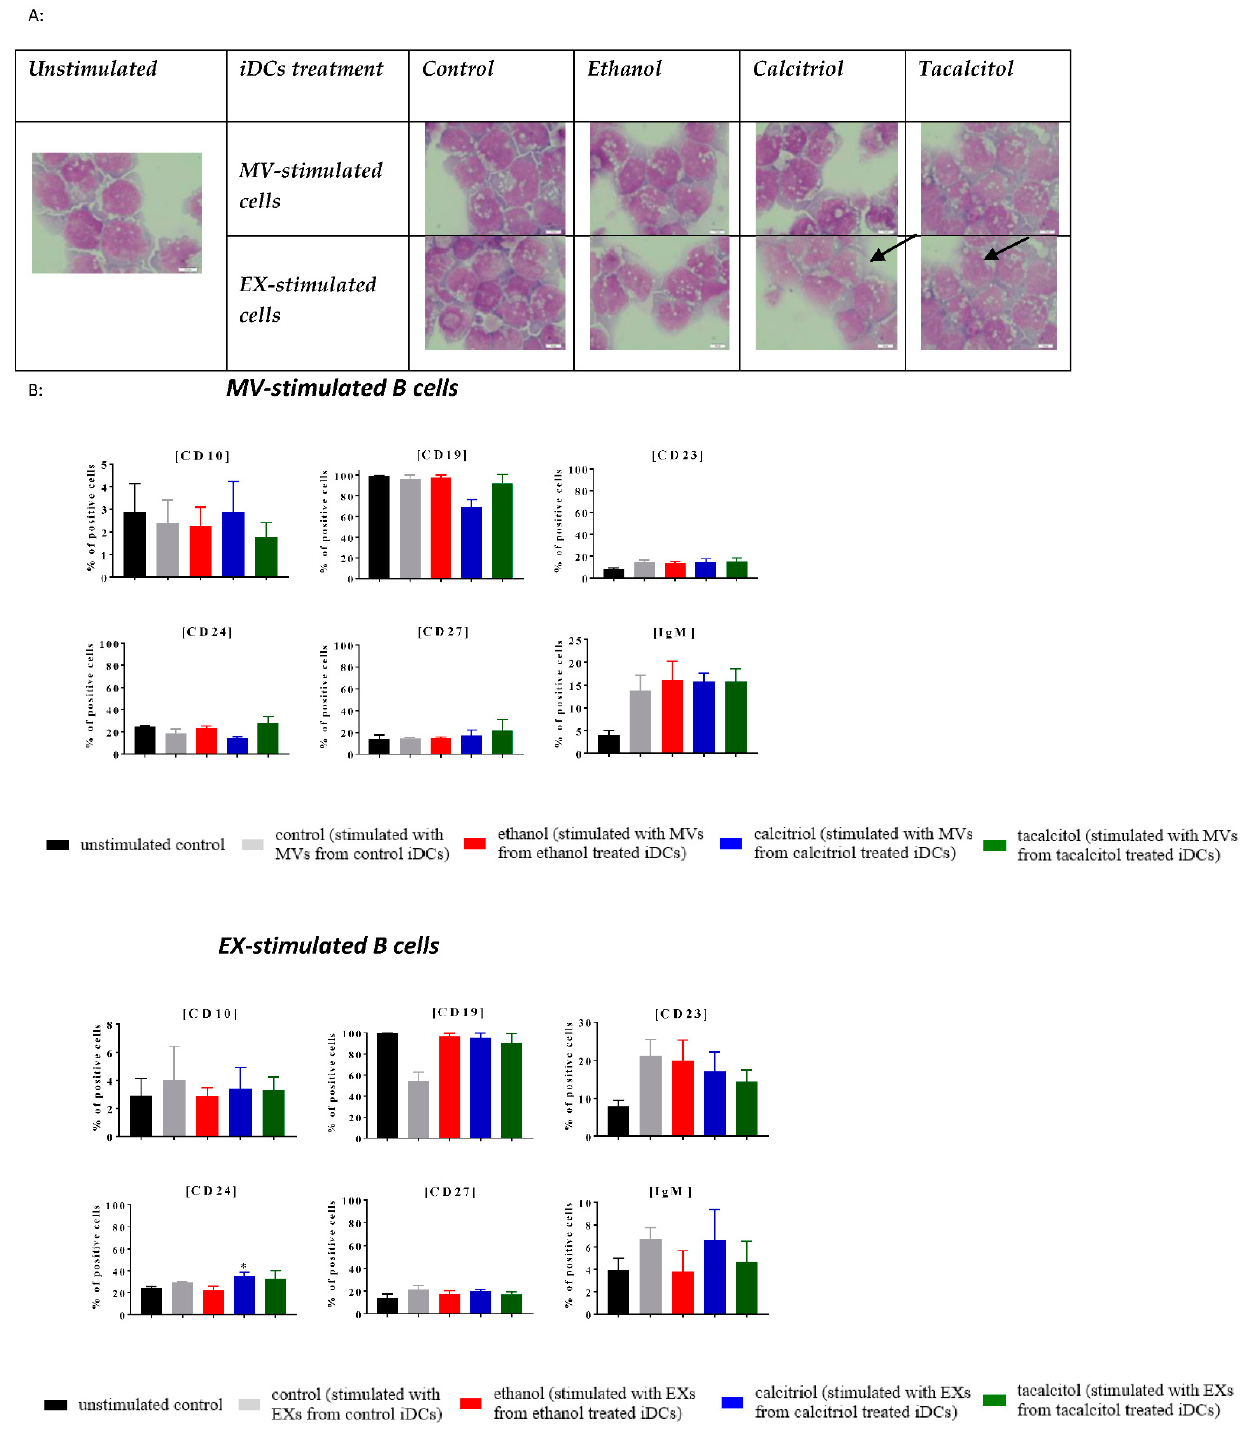
Figure 11. The indirect effect of calcitriol and tacalcitol on SEM cell line after 24 h stimulation with EVs derived from iDCs: ( A ) morphology of EV-stimulated SEM cells, scale bar 10 μ m. Each staining was performed twice; Black arrows indicate vacuolization in cells. ( B ) distribution of differentiation markers by flow cytometry analysis. Mean values and standard deviation are presented. Statistical analysis: Sidak’s multiple comparison tests in comparison with ethanol were performed; significant differences as compared with ethanol (* p < 0.005). Each experiment was performed at least 3 times.